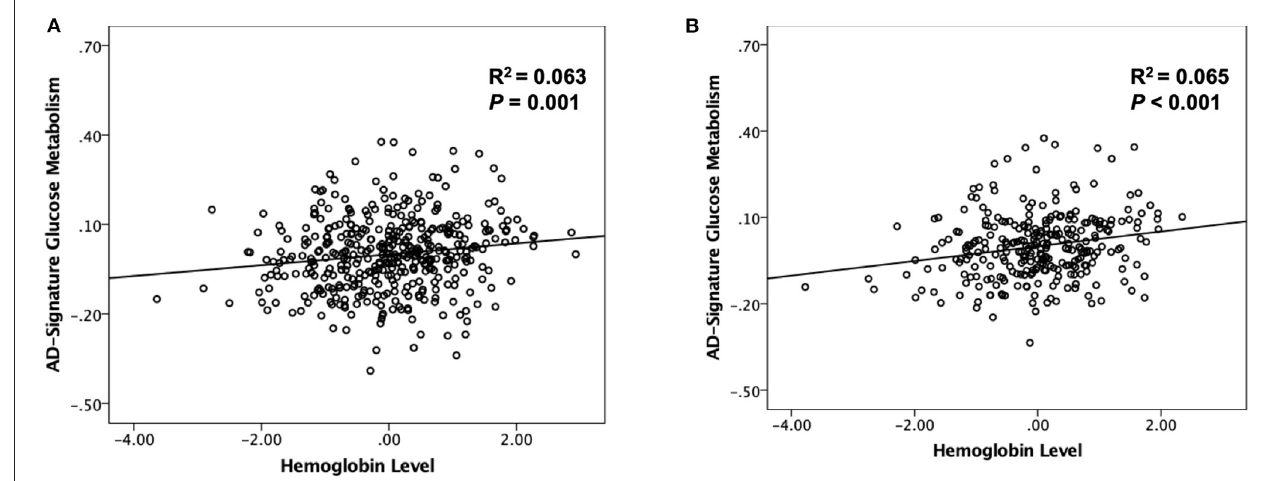
FIGURE 1 | Partial regression plot showing the relationship between hemoglobin level and AD-signature cerebral glucose metabolism (AD-CM) in (A) non-demented and (B) cognitive normal older participants. Multiple linear regression analyses were performed after adjusting for age and sex.